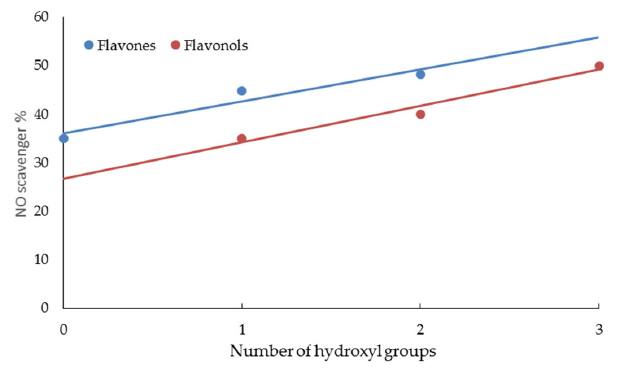
Figure 3. Relationship between NO scavenger % and number of hydroxyl groups of flavones and flavonols.